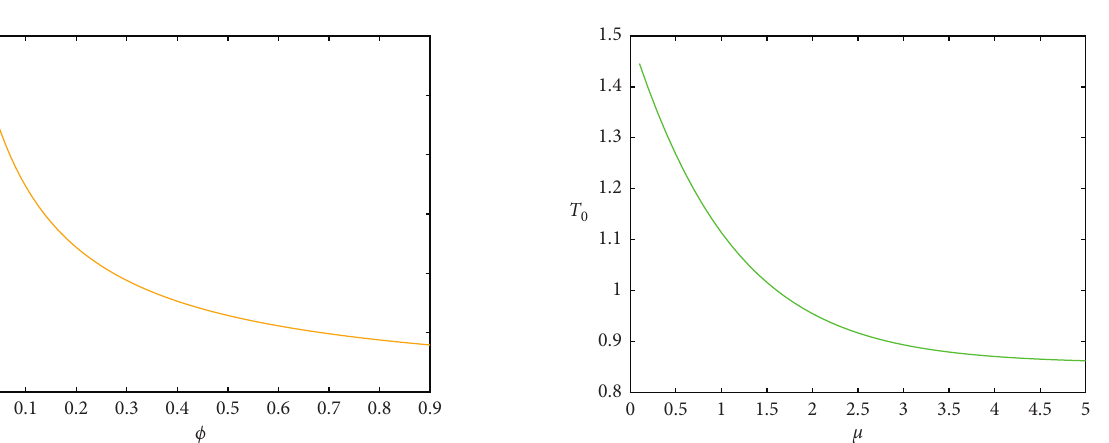
� 0.03, c � 0.1, ϕ � 0.6,